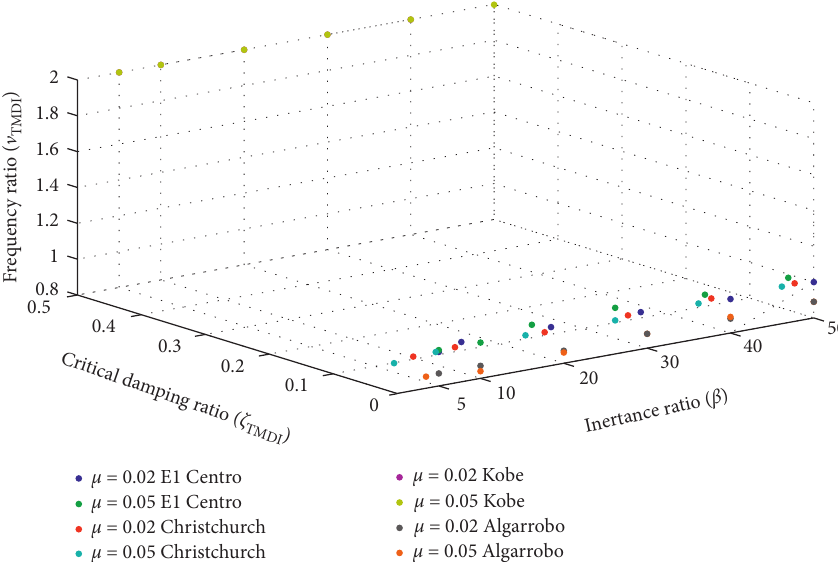
Figure 6: Distribution of the TMDI design parameters determined by the J